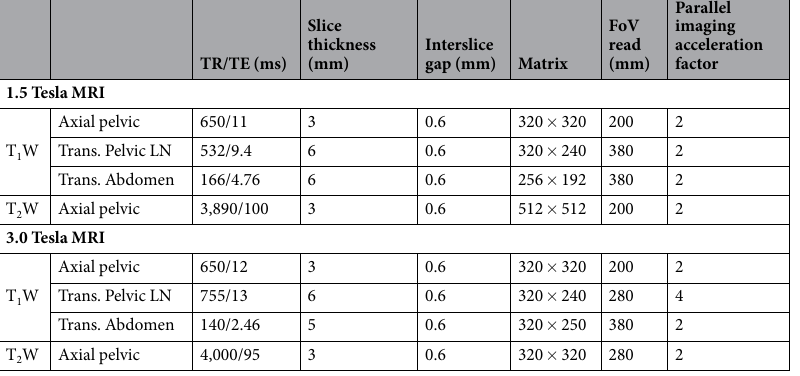
Slice thickness